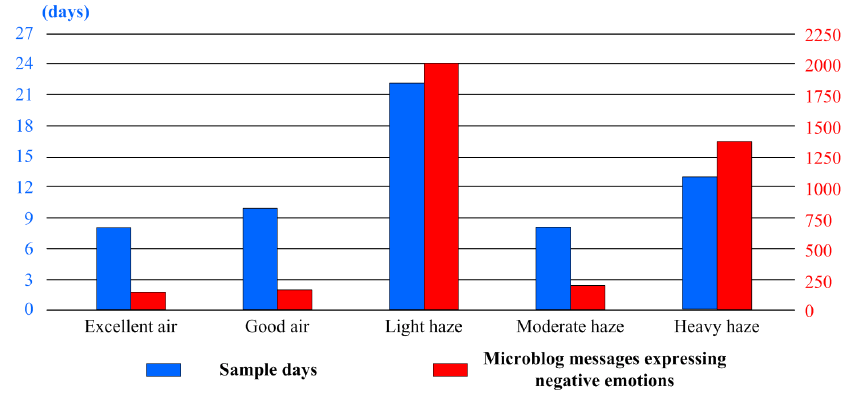
Figure 7. The distribution histogram of sample days and microblog messages expressing negative emotion in January and November.